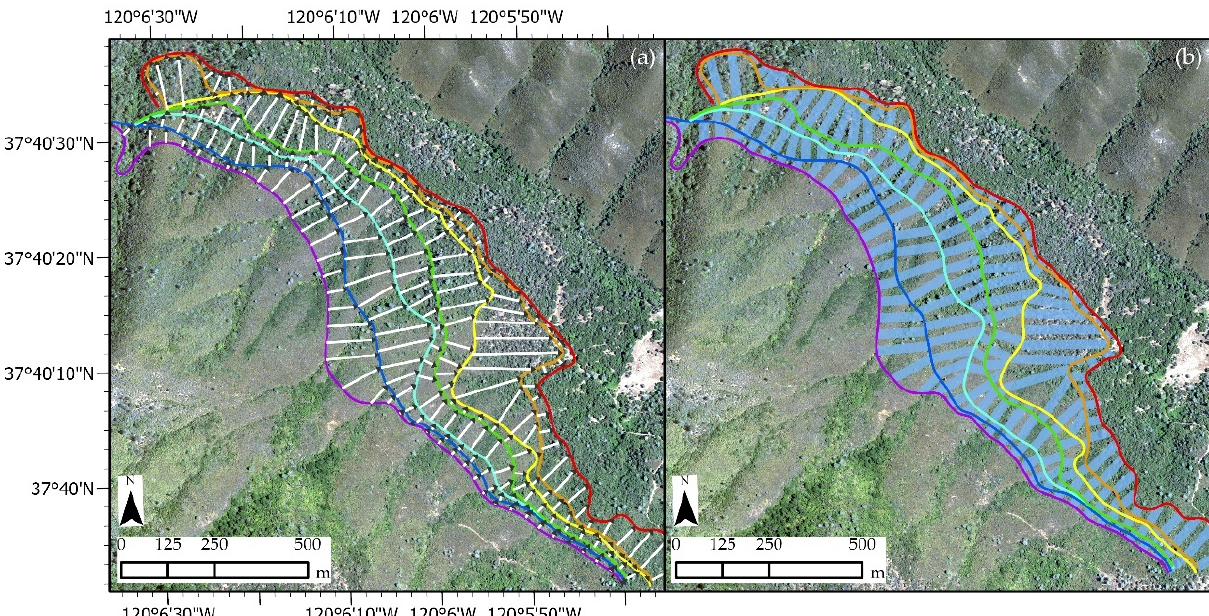
Figure 3. Fire spread vectors and LSUs at Detwiler Fire sequence. ( a ) Fire spread vectors. ( b ) 25 m